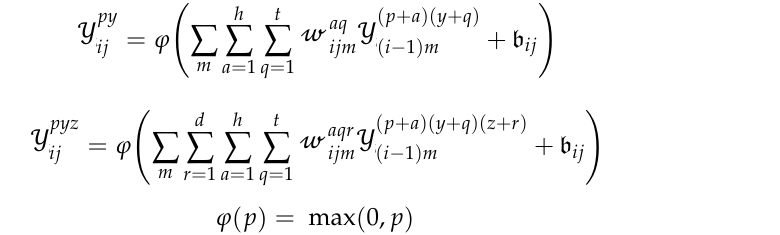
Table 1. The structure of the framework. level-1 layers for model-1 and model-2, and level-2